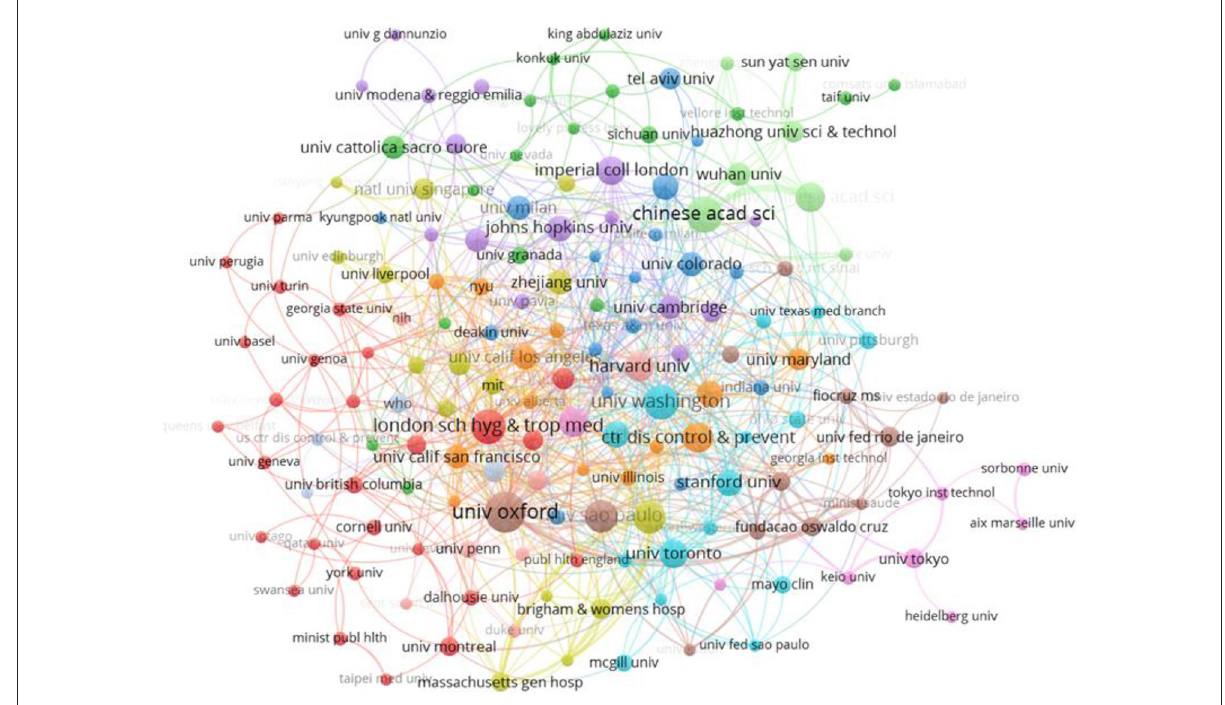
FIGURE4 Knowledge domain map for co-authoring institutions.